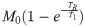
Illustration of the inflow effect.Spins staying within the slice between applications of RF pulses (in black) will not have attained Boltzmann equilibrium (whose magnetization is M0(1-e-TRT1)); spins entering into the slice (in red) which have not been tilted are saturated (whose magnetization is M0); spins entering between the π/2 pulse and acquisition (in blue) will not be involved in the detected signal (whose magnetization is M0 ∼ 0).